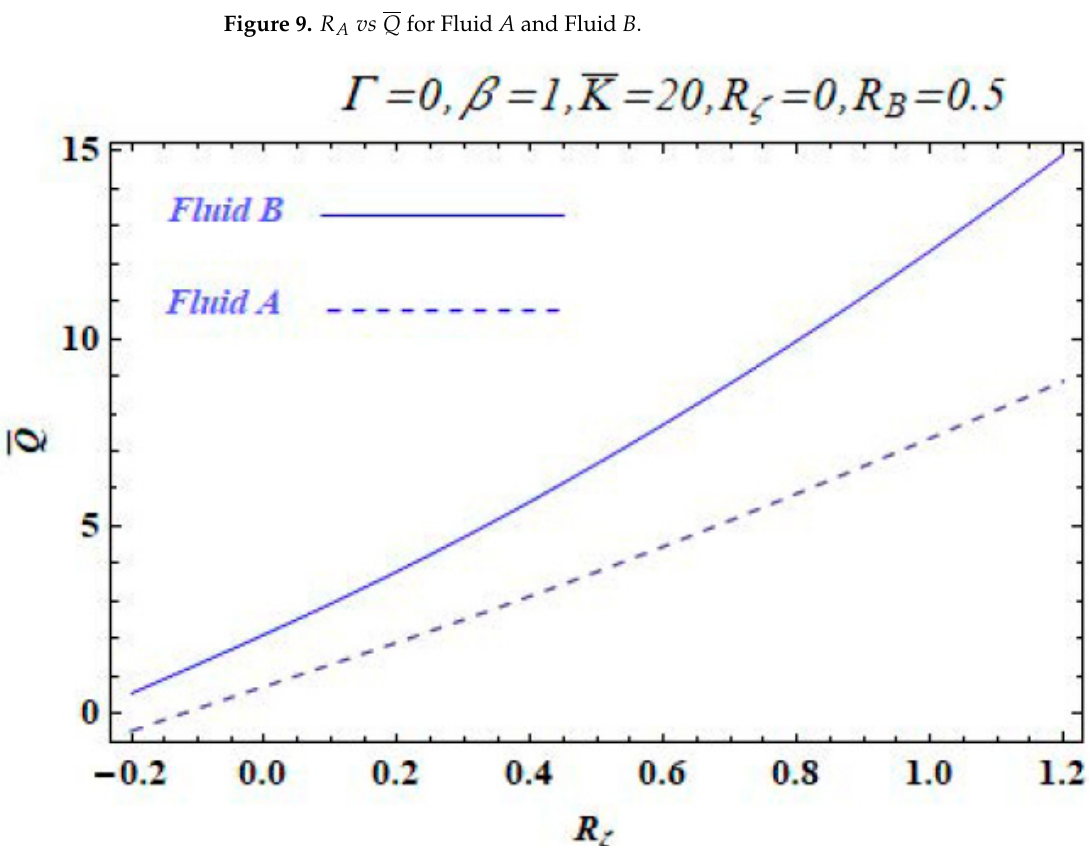
Figure 10. R ζ vs Q for Fluid A and Fluid B 𝑣𝑠 𝑄(cid:3364) for Fluid A and Fluid B . Figure 10. 𝑅 (cid:3085) 𝑣𝑠 𝑄(cid:3364) for Fluid A and Fluid B . Figure 10. 𝑅 (cid:3085)